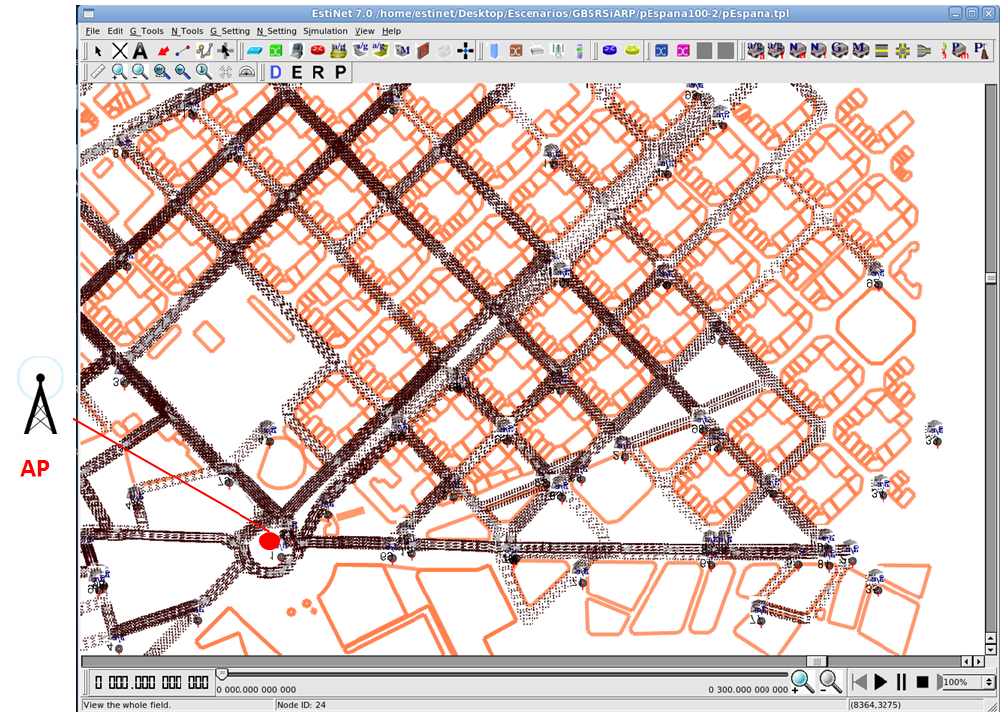
Figure 3. Simulation scenario. Eixample district of Barcelona, Spain, with an Access Point (AP). Buildings (orange lines) from OpenStreetMap are